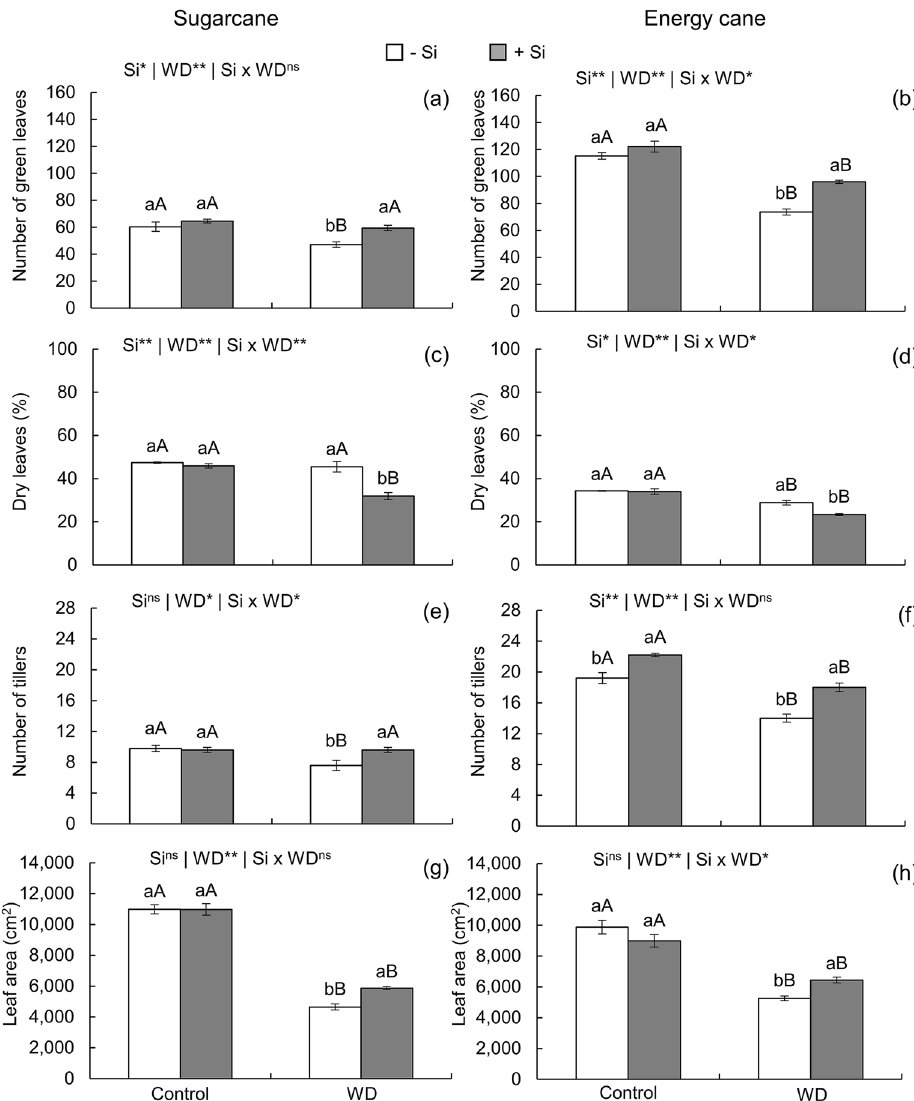
Figure 7. Number of green leaves, percentage of dry leaves, number of tillers, and leaf area in sugarcane ( a , c , e , g ) and energy cane ( b , d , f , h ) in the absence of Si (-Si) and with Si applied via fertigation associated with foliar spraying (+ Si) under water adequate regime (control) and severe water deficit (WD) for a period of 7 to 160 days after transplanting. ** and * : significant at 1 and 5% probability, respectively; and ns : not significant by the F-test. Different lowercase letters indicate differences in relation to Si in the same water regime; different capital letters indicate differences in relation to the water regime in the same conditions of Si supply, both by the Tukey test. Bars represent the standard error of the mean; n =